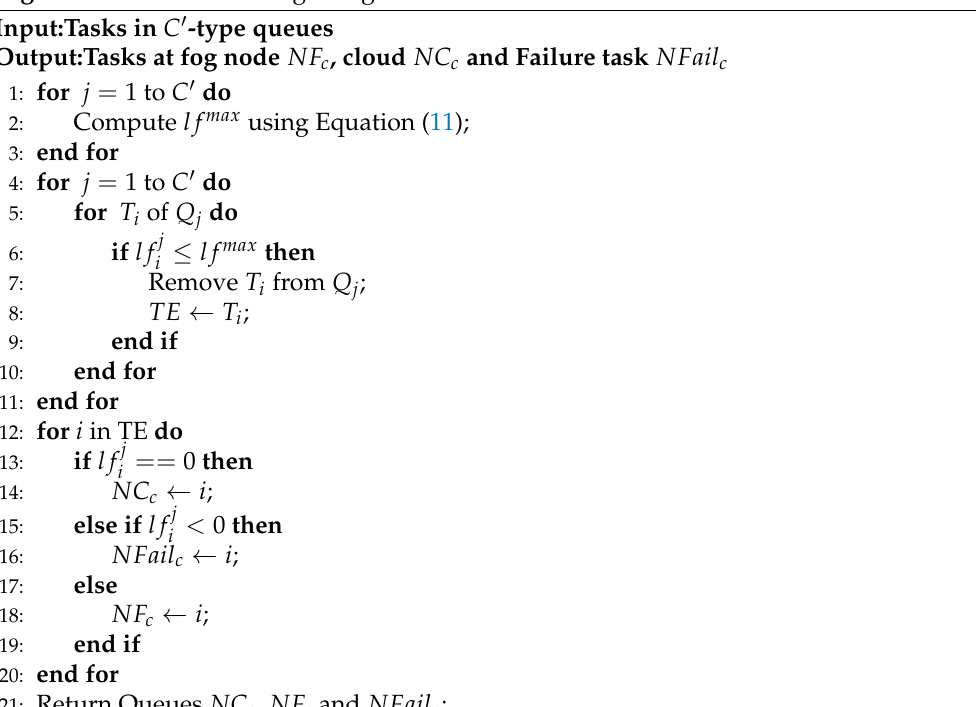
Algorithm 3 Task offloading at fog